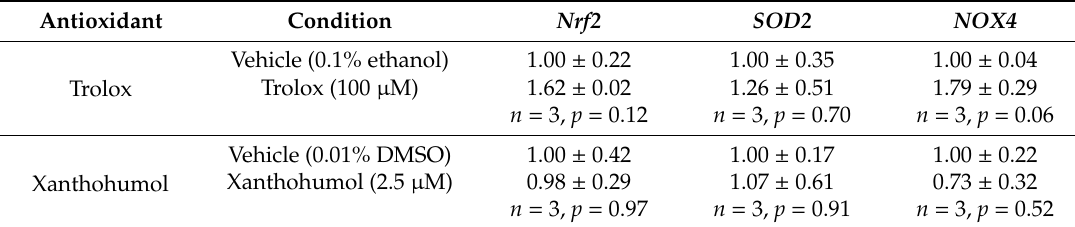
Table 1. Lack of e ff ect of xanthohumol and Trolox on Nrf2, SOD2, and NOX4 expression in primary optic nerve head